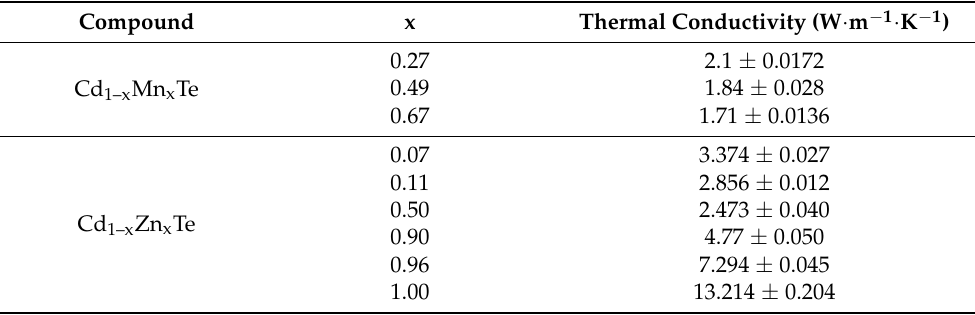
Figure 4. Phase ( a ) and amplitude ( b ) characteristics of CdBeTe crystals for front configuration as a function of the modulation frequency. Squares refer to experimental points, and lines are the best fits of Equations (7) and (8) performed with the least square method. Table 2. Thermal conductivity of Cd 1–x Mn x Te [15] and Cd 1–x Zn x Te crystals